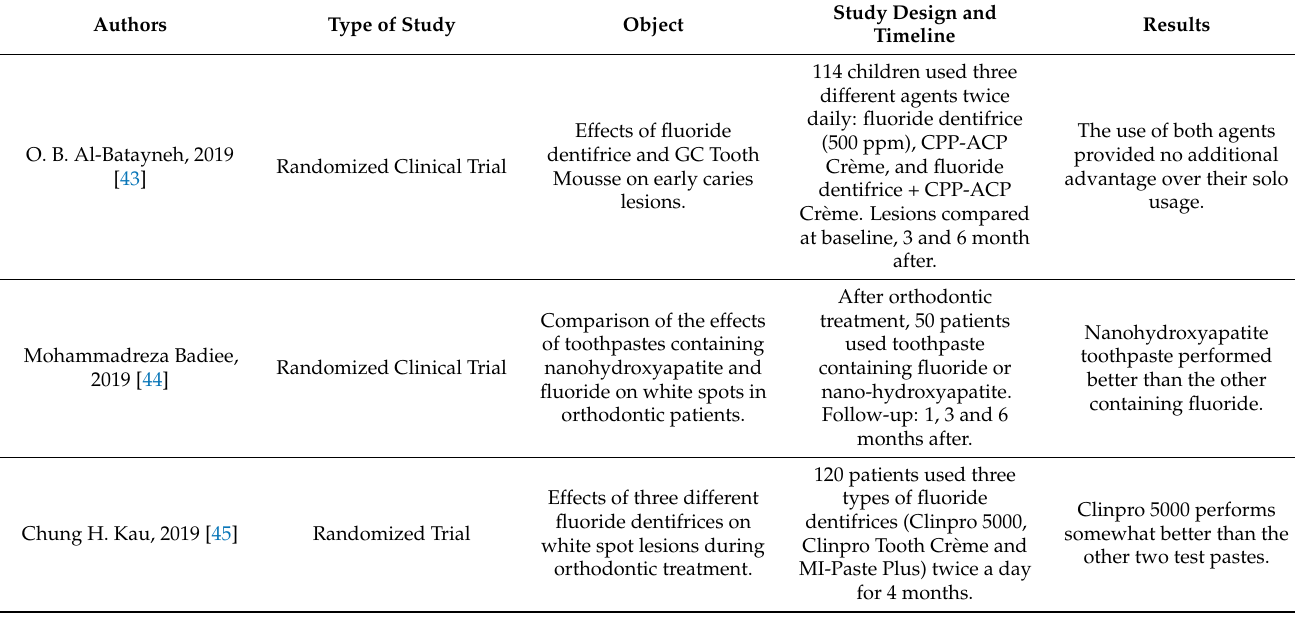
Figure 4. PRISMA flowchart diagram of the inclusion process. The literature search Preferred Reporting Items for Systematic Reviews and Meta-Analyses (PRISMA) flow diagram. Table 1. Descriptive summary of item